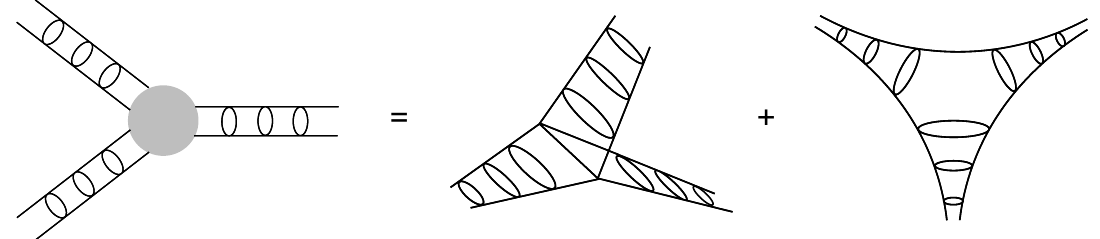
Figure 1. The connected fermion six-point function, to leading nontrivial order in 1 =N , is given by a sum of Feynman diagrams, of the kind shown on the right. This consists of three fermion four-point functions, ladders, that are glued together. There are two classes of diagrams, as shown on the right; only the second is planar. This (cid:12)gure, as well as all others, is for q = 4 SYK, and the lines denote the full propagators: they should be dressed with